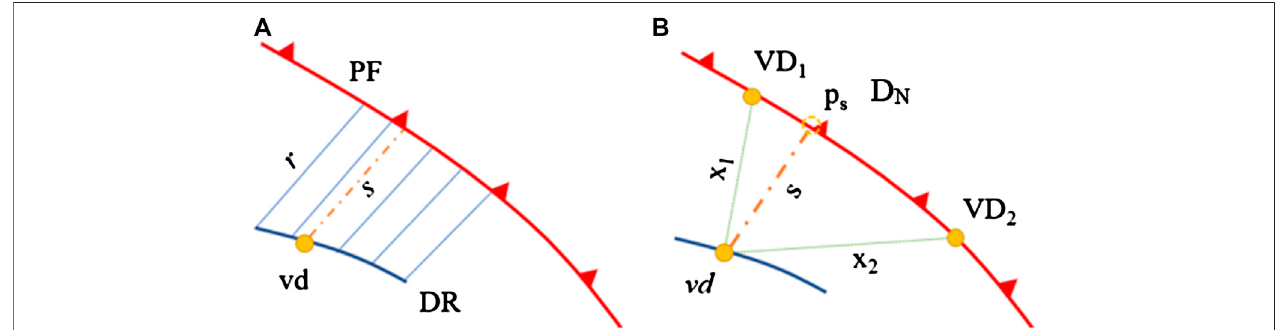
FIGURE 4 | The measurements obtained from the georeferenced maps and displacement data of each earthquake in the dataset distinguishing the principal fault (PF; red line) and distributed ruptures (DR; thick blue line). (A) The de fi nition of the distances “ r ” and “ s, ” and (B) p s is the nearest point of the PF to the vd . The D N at p s is calculated considering VD 1 , VD 2 and the corresponding distances. See text for details.